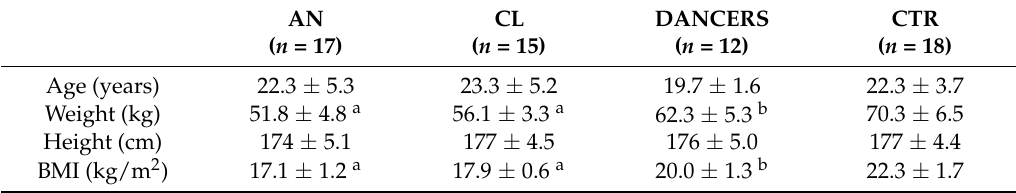
Table 1. Anthropometric measurements of 62 males individuals, according to leanness groups. AN ( n = 17)